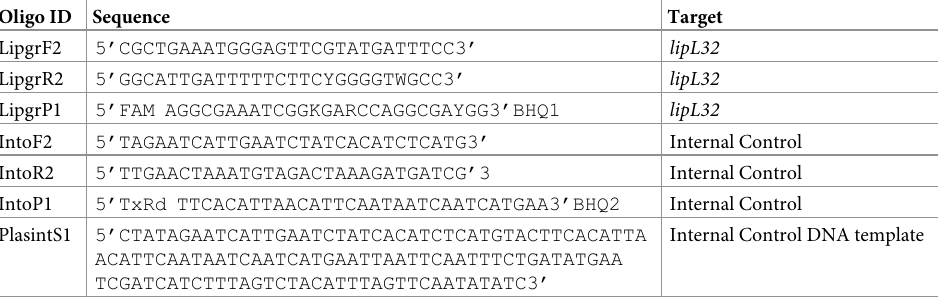
Table 3. Sequences and modification of the primers, probes and synthetic DNA template IC used to optimize the